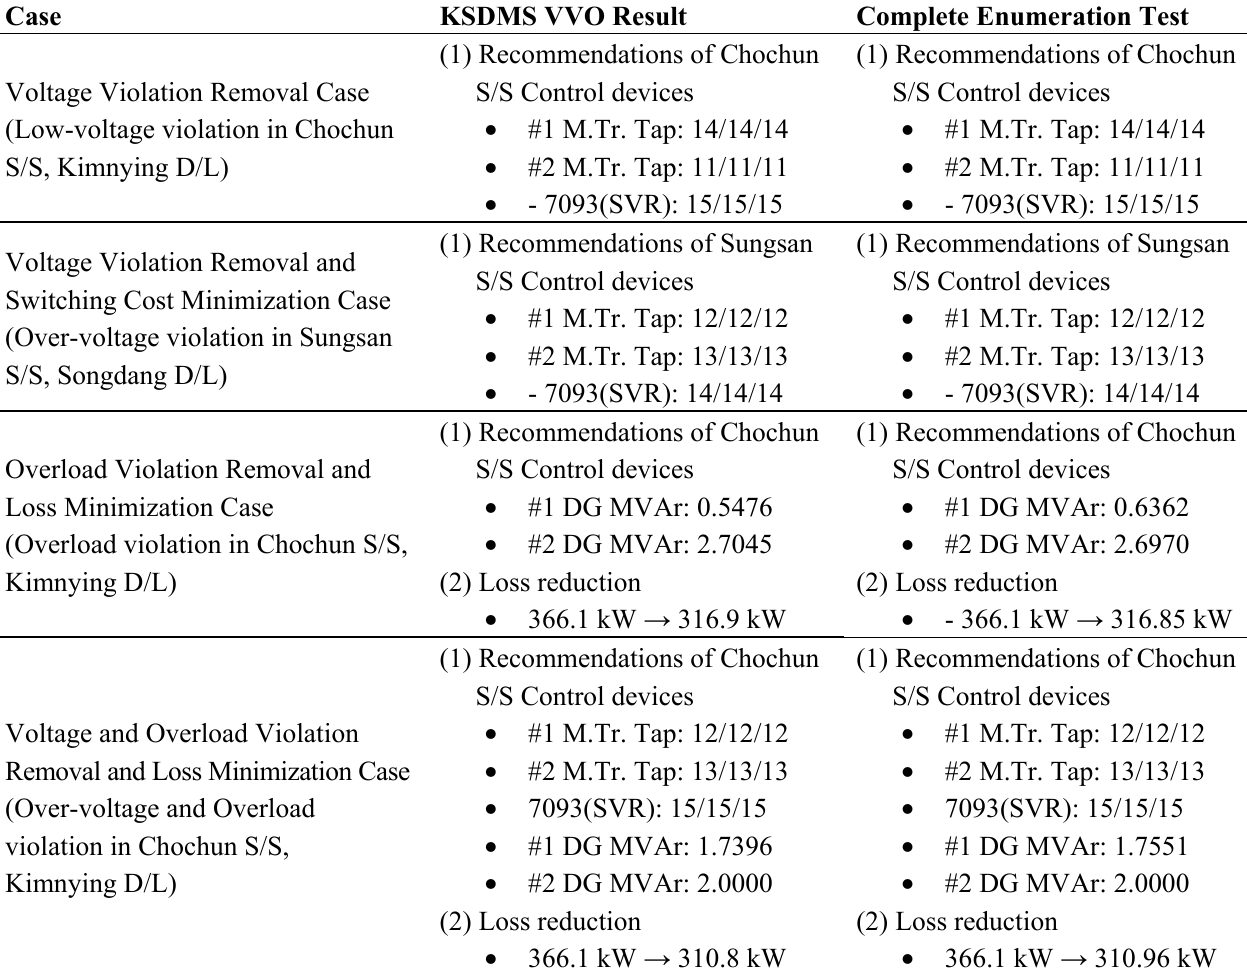
Table 8. Results of the VVO functional test.